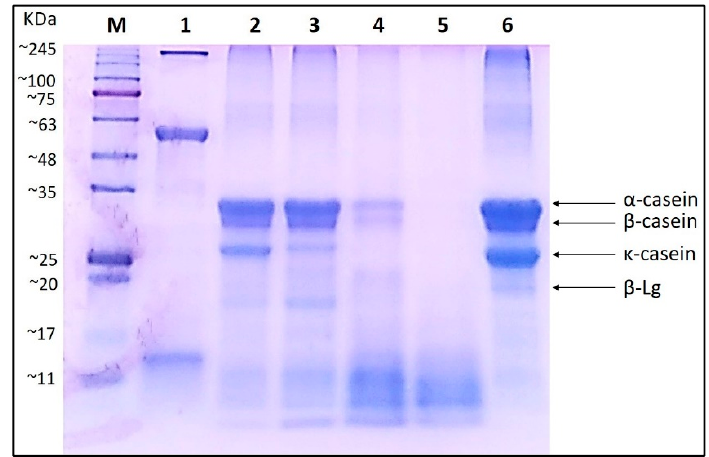
Figure 1. Electrophoresis of bovine milk casein hydrolyzed by curly kale leaf extract. M—prestained protein molecular weight marker; lane 1—curly kale extract; lanes 2 to 5—casein hydrolyzed by curly kale extract after 1 h, 4 h, 8 h, and 24 h, respectively; lane 6—solution of bovine milk casein (10 µL of 0.25%).